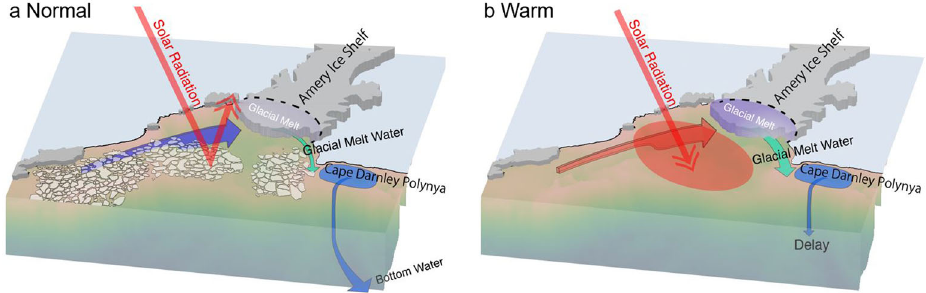
Fig. 5 Schematic oceanic and cryospheric state in the Prydz Bay and off Cape Darnley. a Climate condition in normal summers and subsequent dense shelf water formation in early-winter and b those in warm